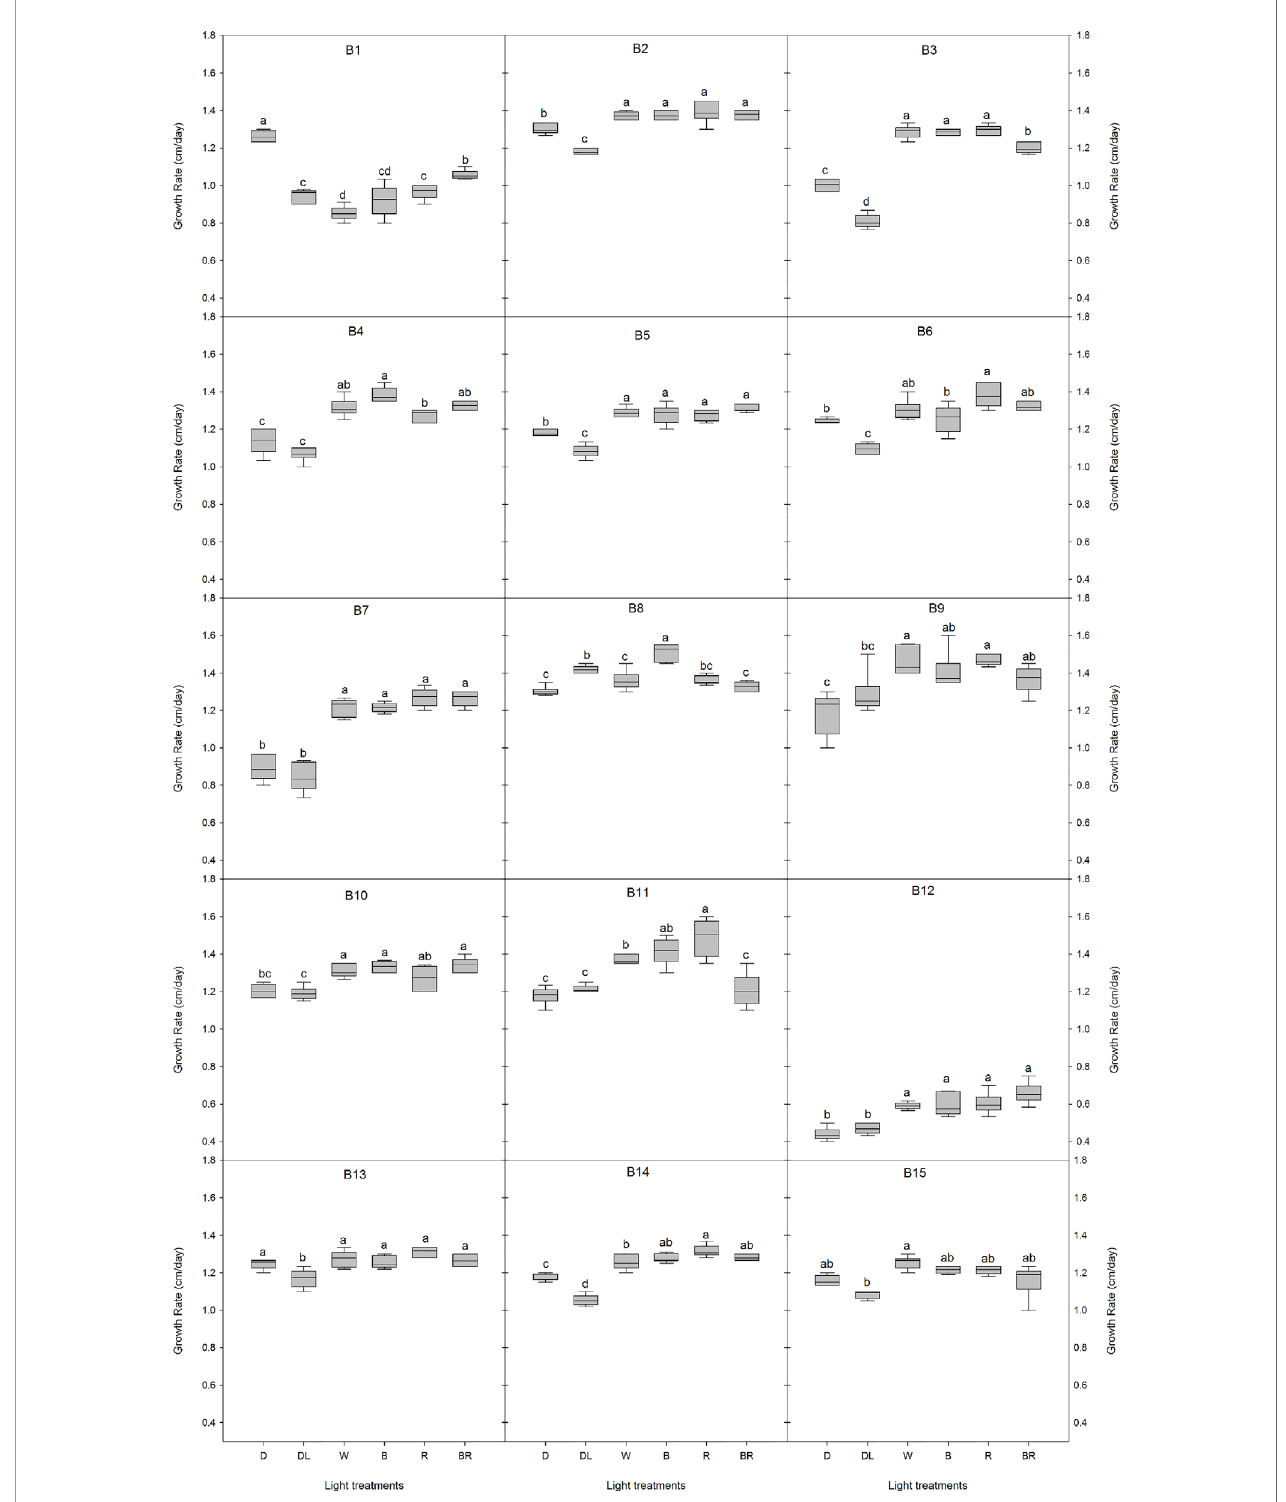
FIGURE 2 | Effects of light quality on the growth rate of 15 Botrytis cinerea isolates. Six light treatments were analyzed namely dark (D), daylight (DL), white (W), blue (B), red (R), and blue+red (BR). Different letters indicate statistical differences between light treatments for each isolate based on Tukey ’ s test (p ≤ 0.05), except for B2 and B15 where a non-parametric Kruskal-Wallis followed by a post-hoc Dunn ’ s test (p ≤ 0.05) was performed.